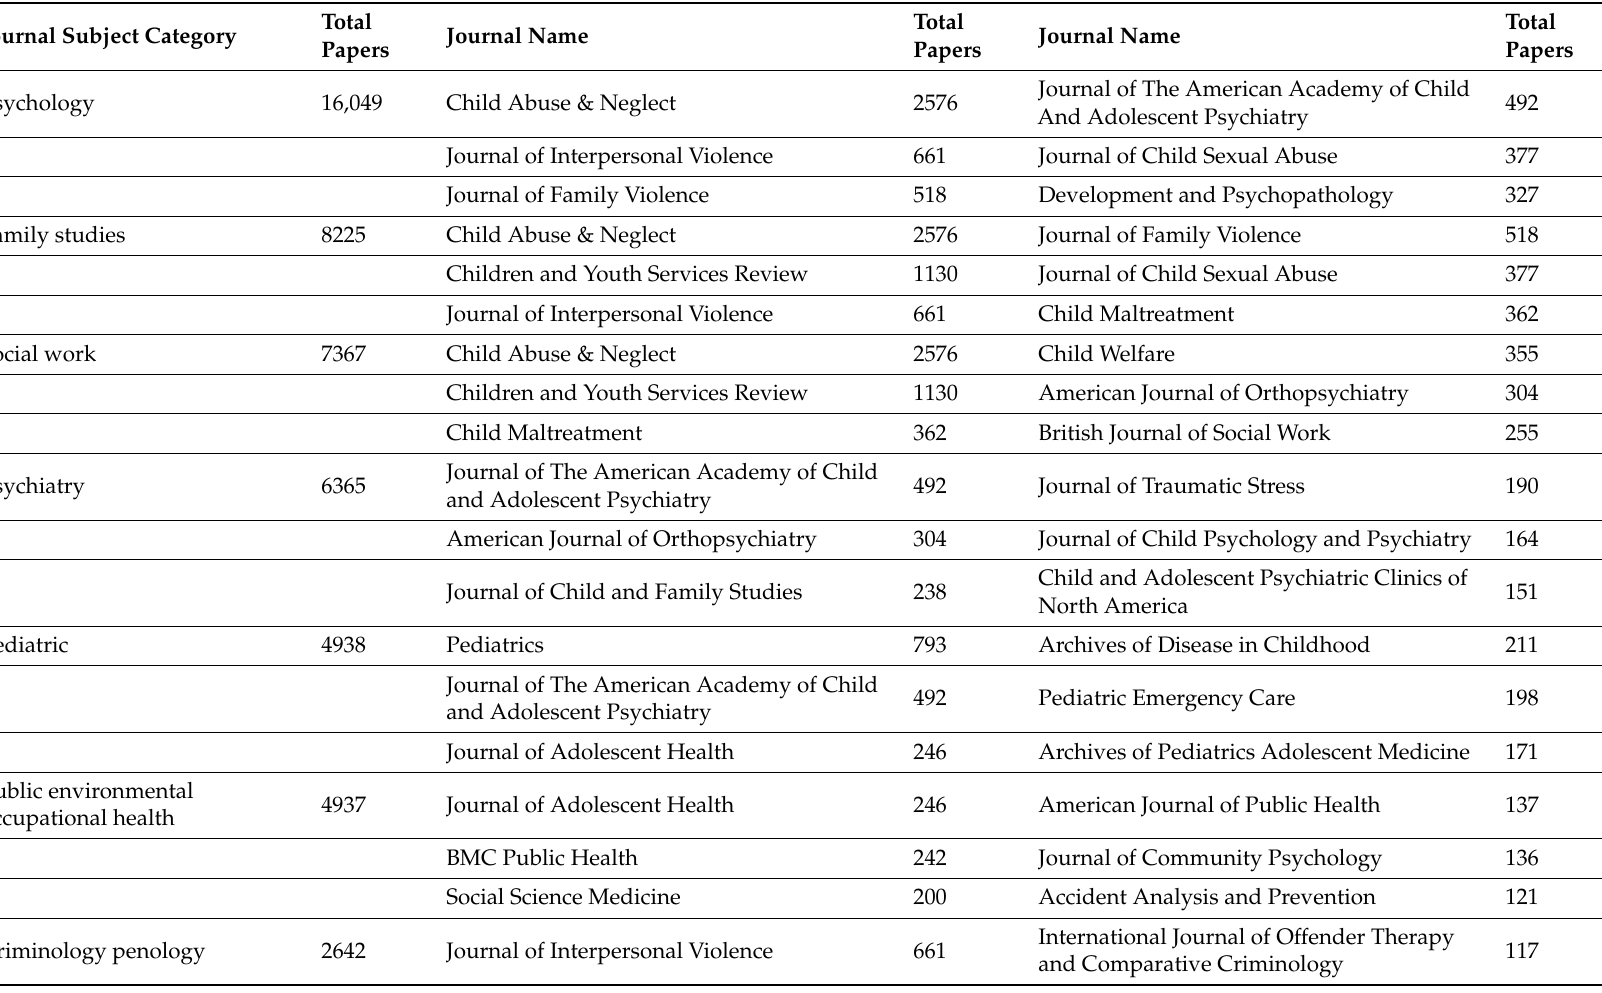
Table 2. Journal subject categories and the journals which included those subject